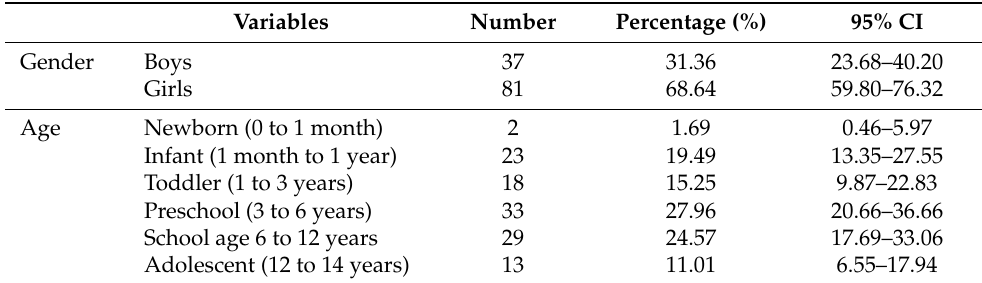
Table 1. Demographic data of pediatric study